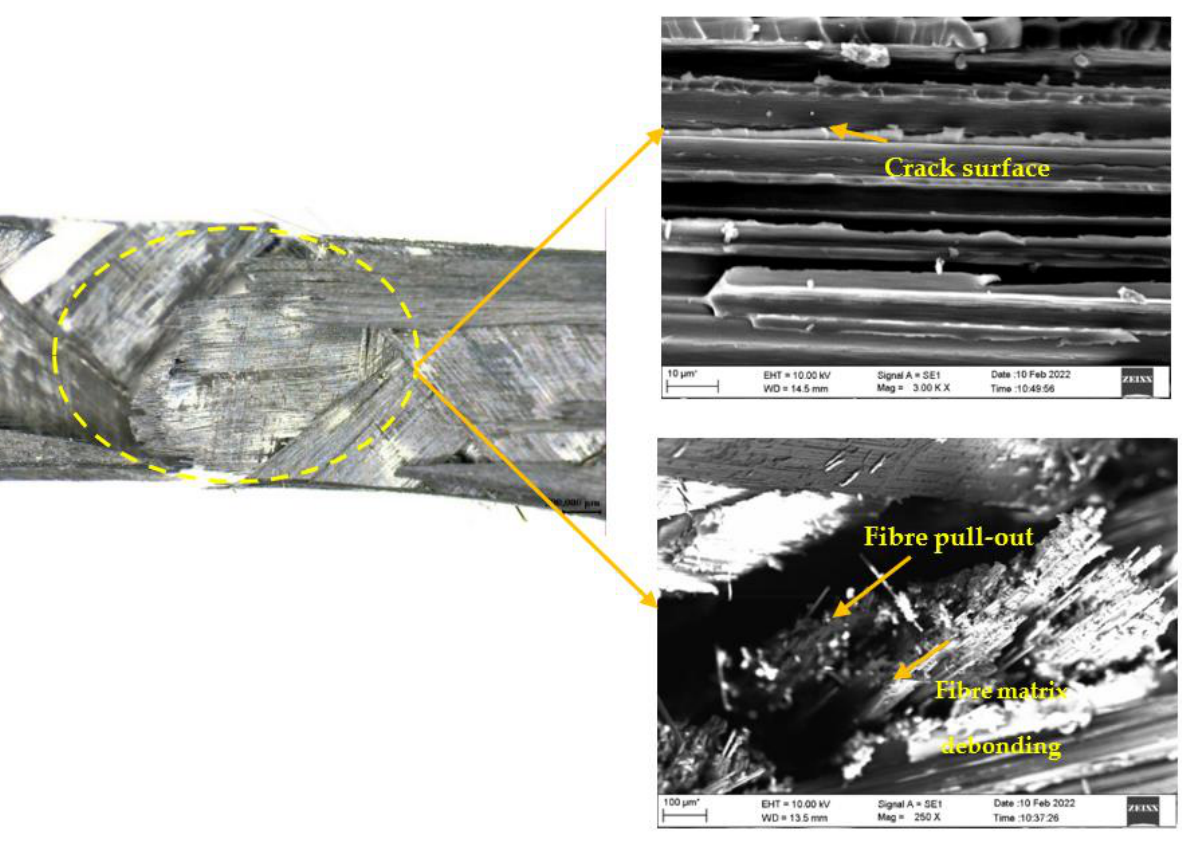
Figure 12. SEM images of tensile failure specimens of unfilled CFRP composite.